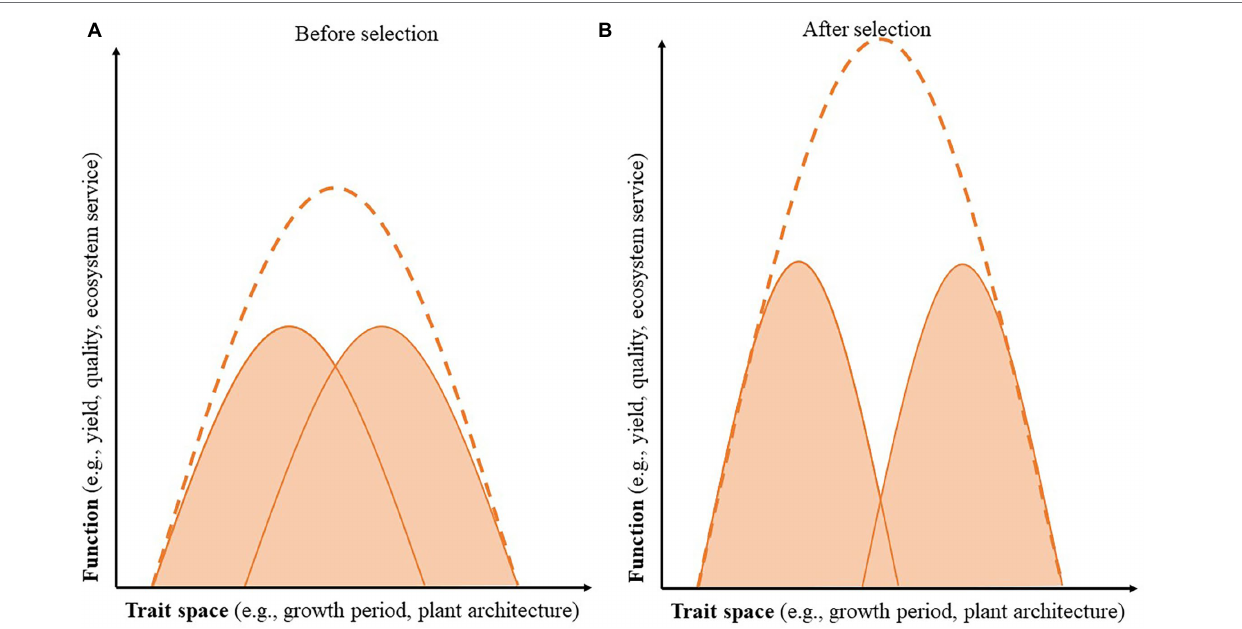
FIGURE 2 | Selecting component species for niche differentiation enhances the combined function of the intercropping system. The x-axis represents the trait space, which may represent a temporal (e.g., growth period and maturity date), spatial (e.g., rooting depth and plant height), or other niche. The y-axis represents the desired cropping system function, including crop yield or quality, or a range of ecosystem services. The shaded areas represent each component species, and the dotted line represents the combined performance of the intercropping system. Before selection (A) there is more competition between component species (or overlap between the two curves), and after selection for niche differentiation (B) there is decreased competition between the component species, allowing for greater combined function of the cropping